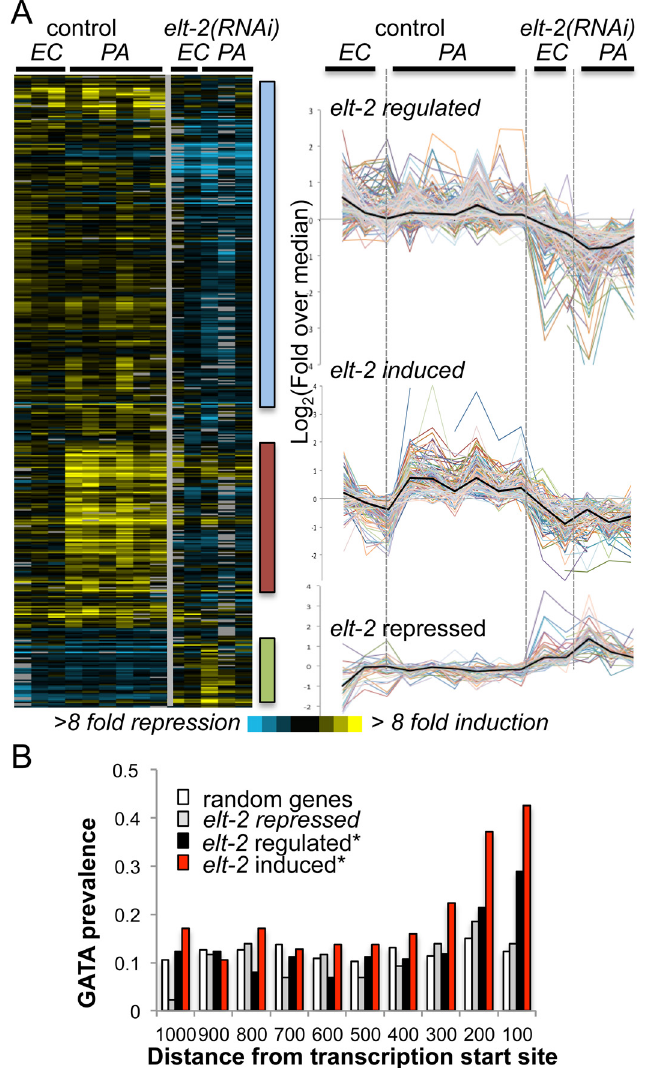
Fig 1. elt-2 regulated genes. A . microarray analysis . Gene expression profiles for 426 transcripts differentially expressed between elt-2(RNAi) and control-treated wildtype worms, when exposed to P . aeruginosa (PA, 12 hours), compared to E . coli ( EC ). Left, heatmap of raw values (log 2 (fold change over reference RNA)), with bars highlighting clusters of interest; right, curves depicting median-centered expression profiles; black curves represent the median. B . GATA motif distribution . Measured for the consensus TGATAA in 1000bp upstream sequences of genes of the designated subsets; shown as #motifs/ gene/100bp; asterisks mark significant deviations from random distribution (p < 10 – 8 , χ 2 ).